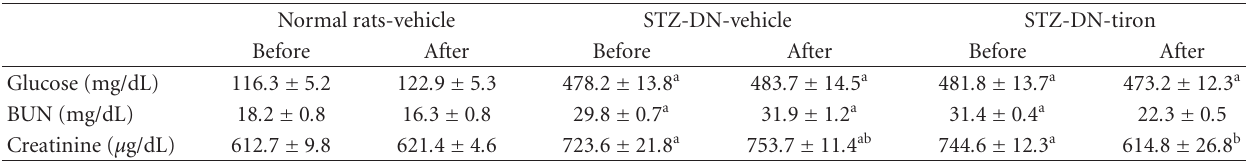
Table 2: Changes in serum glucose, BUN, and creatinine levels in normal rats or streptozotocin-induced diabetic rats (STZ-DN) receiving repeated i.p. injection with vehicle or tiron (300 mg/kg) three times a day for 7